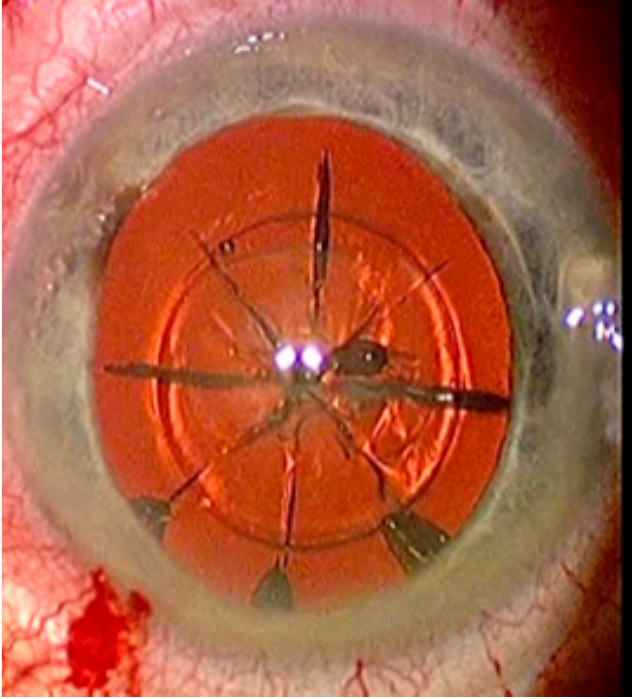
Figure 3. The planned cutting lines and areas are marked grey, the red bars are the calculated safety distances.